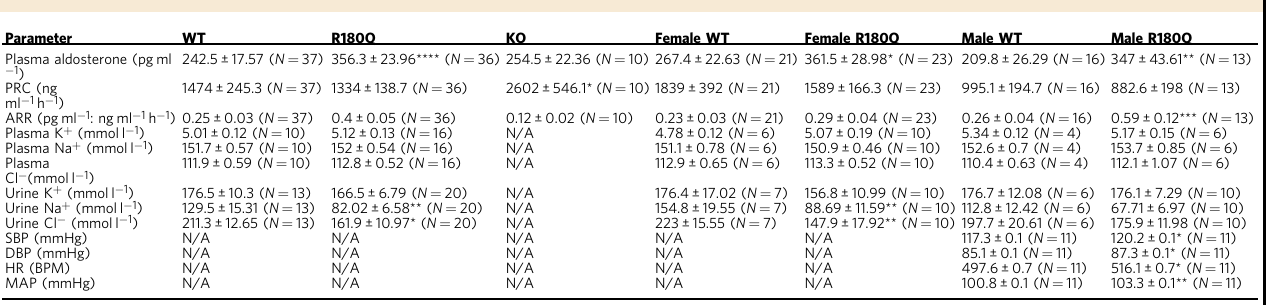
Table 1 Phenotypical parameters of WT, Clcn2 R180Q/ + and Clcn2 − / − mice.